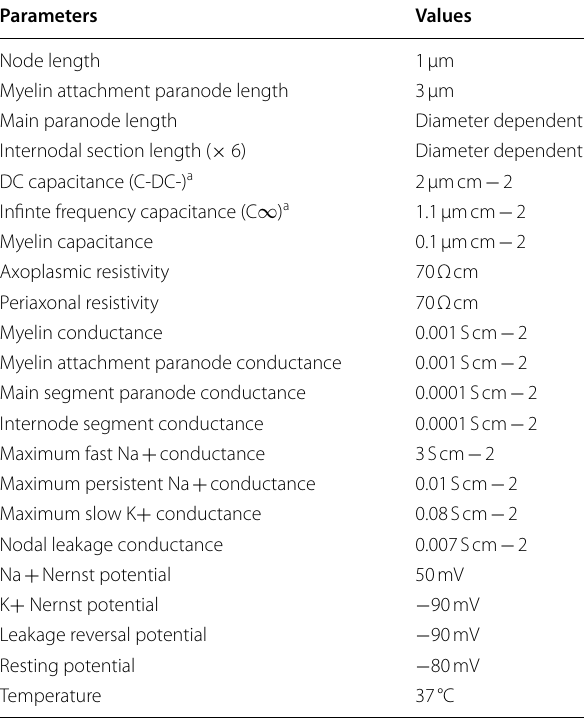
Table 2 Parameters used for MRG simulation of peripheral mammalian